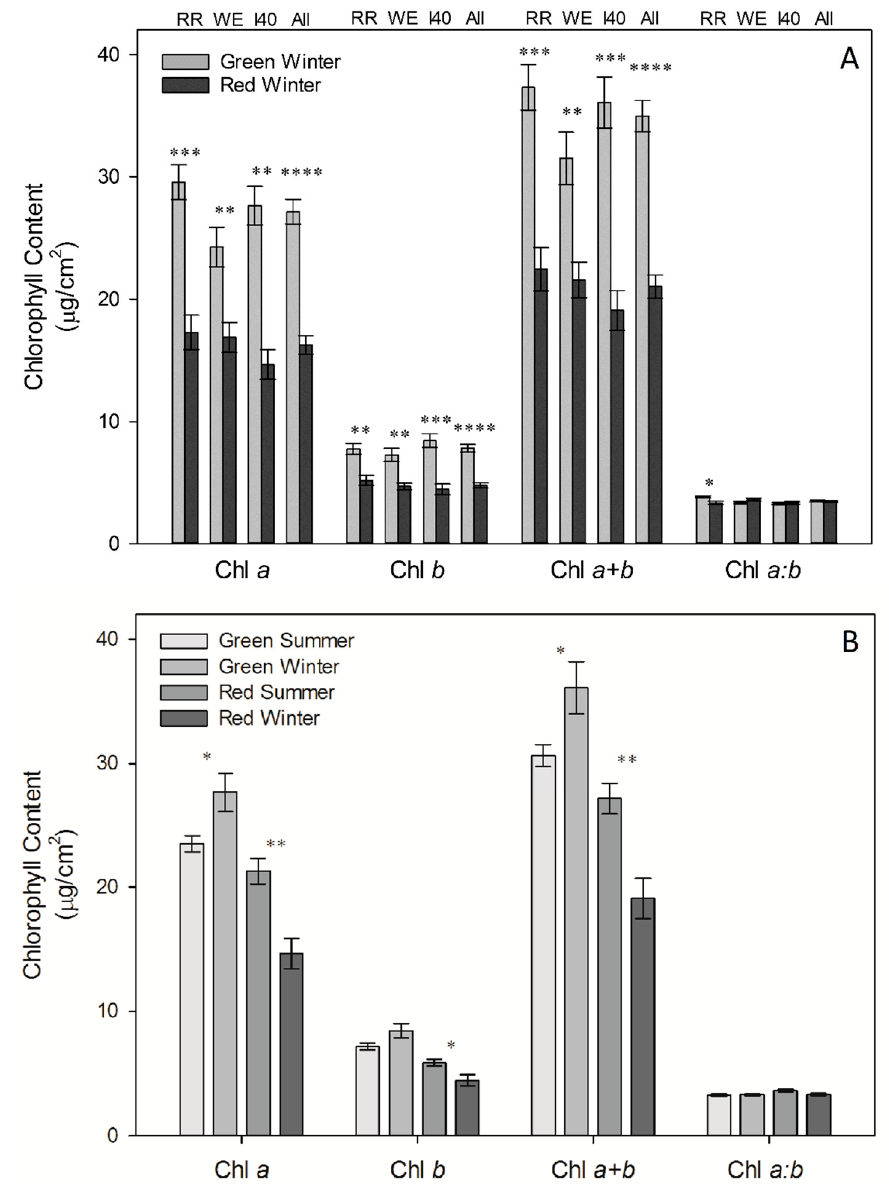
Figure 2. ( A ) Mean chlorophyll content per unit leaf area during winter for green ( n = 5) compared to red ( n = 5) leaves ± SE at each site for RR, WE, I40, and combined sites (see labels at top of figure); ( B ) Mean summer chlorophyll content for winter-red ( n = 6) and winter-green ( n = 6) portions of I40 site compared with winter chlorophyll content ( n = 5 for both sides) ± SE. Significant differences between red versus green leaves (A); and summer versus winter leaves (B) denoted by asterisks (* p < 0.05; ** p < 0.01, *** p < 0.001, and **** p <